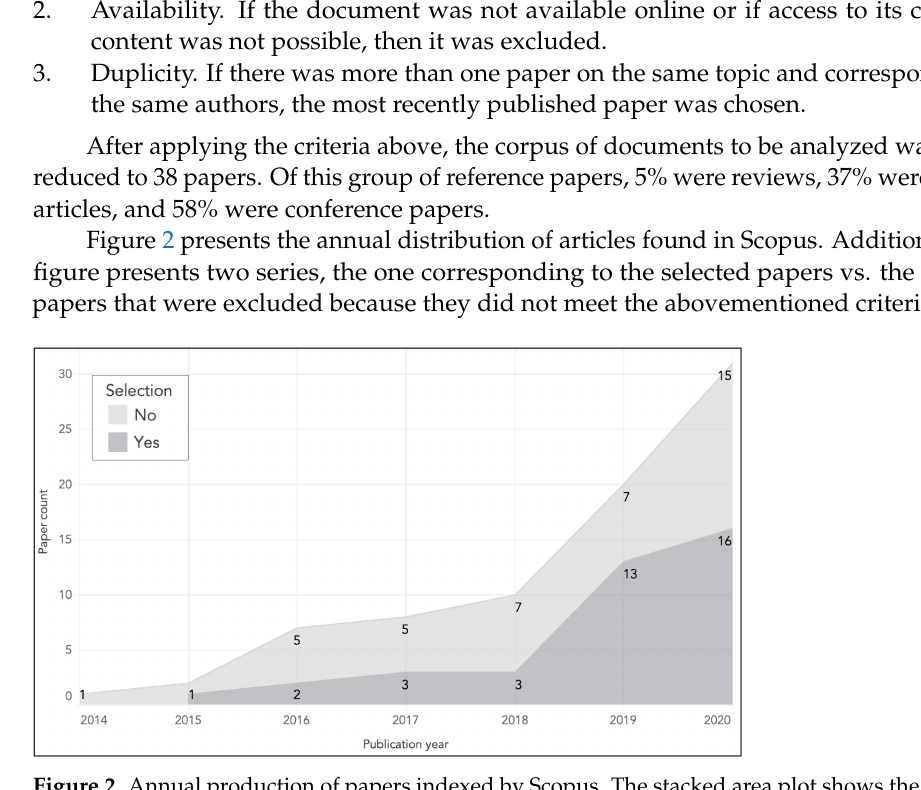
Figure 2. Annual production of papers indexed by Scopus. The stacked area plot shows the temporal evolution of papers related to the topic recommendation systems and knowledge